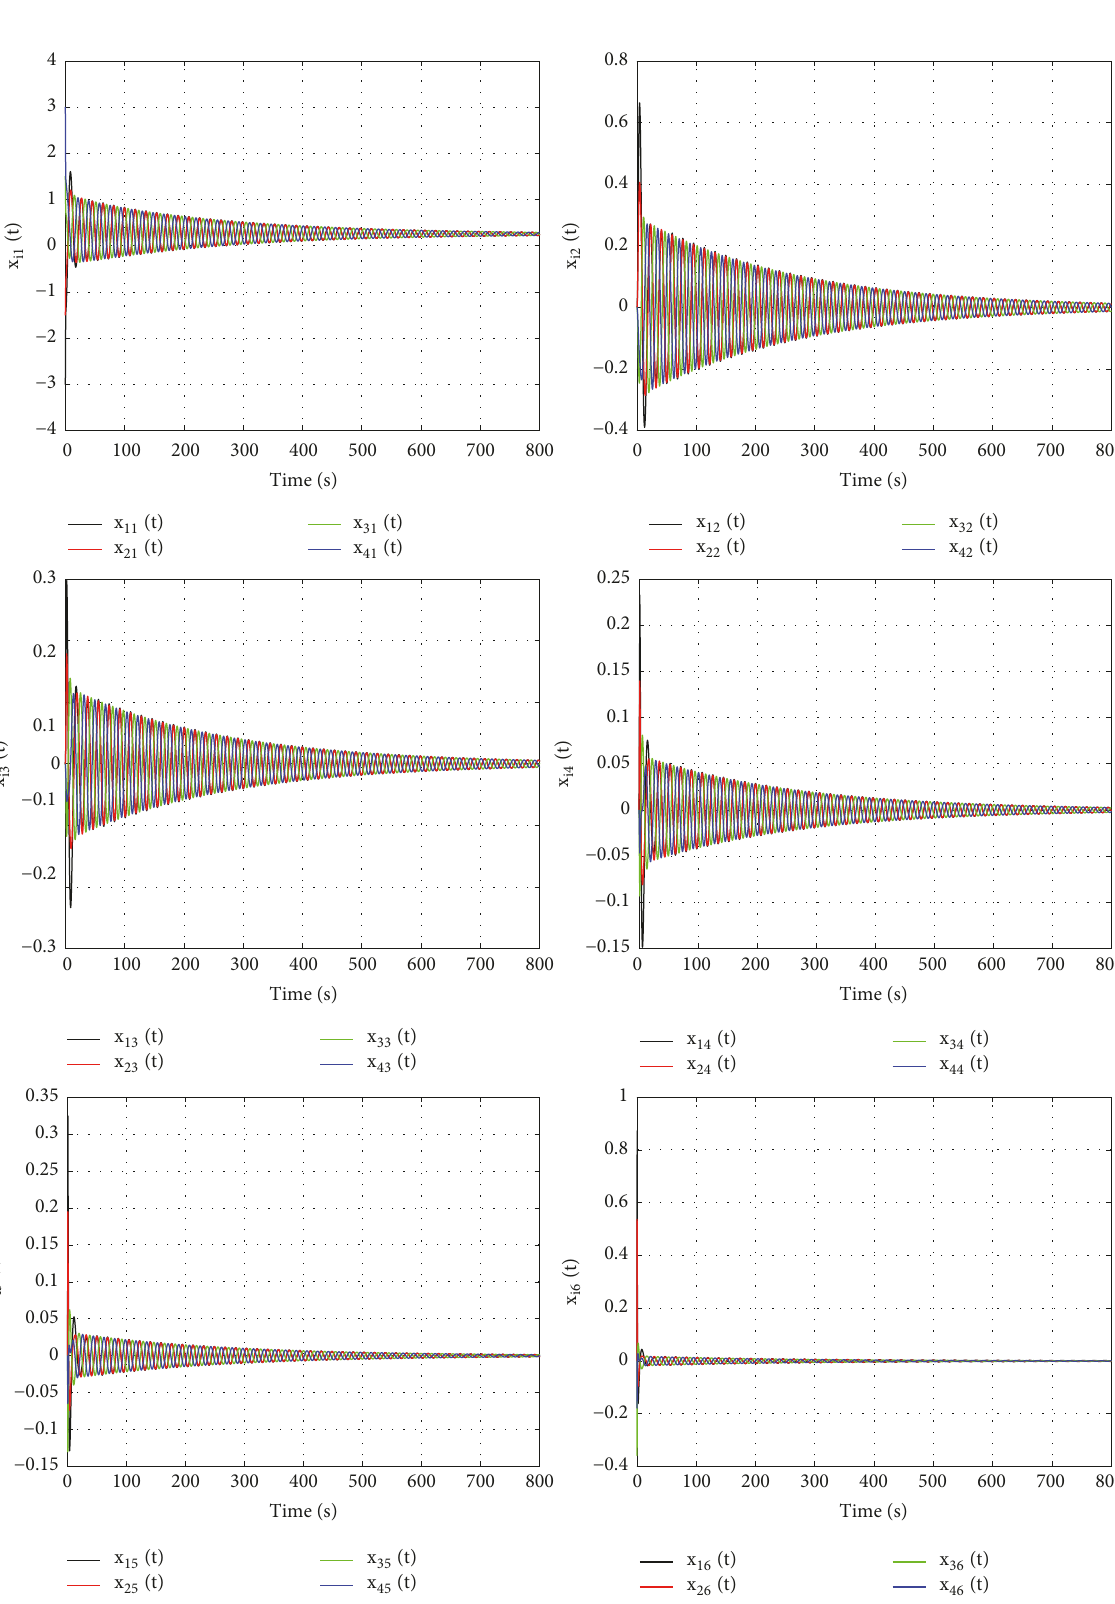
Figure 13: The trajectoriesof all agents’states inthe FOMASwith sextuple integraland asymmetric time-delays whenall 𝜏 𝑚 < 𝜏 inExample